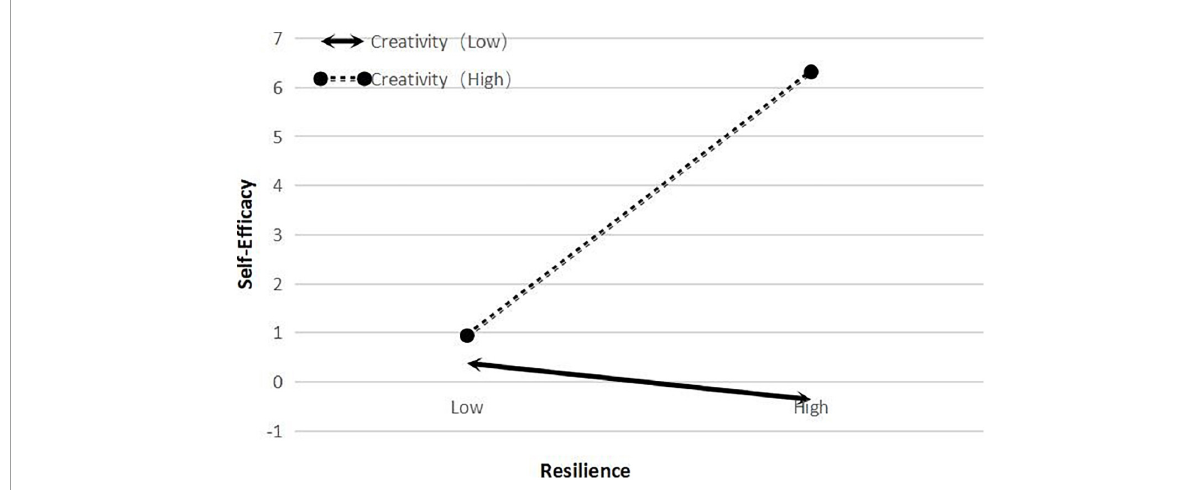
FIGURE2 The relationship between resilience and self-efficacy for high and low scores for creativity.